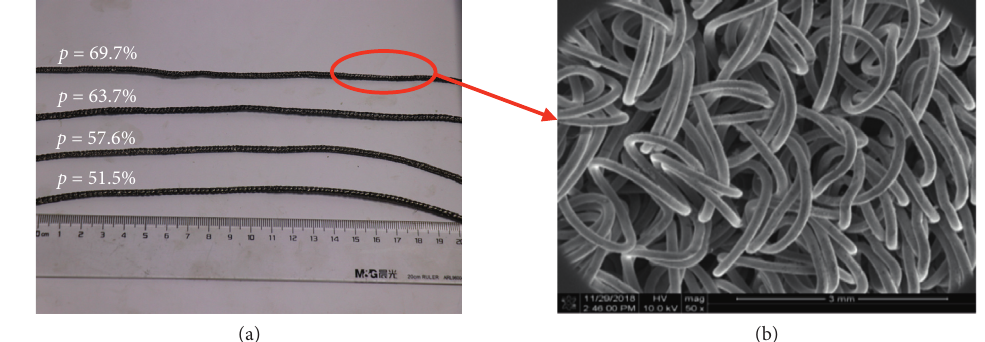
Figure 3: (a) MRSM test samples. (b) SEM of MRSM test sample.